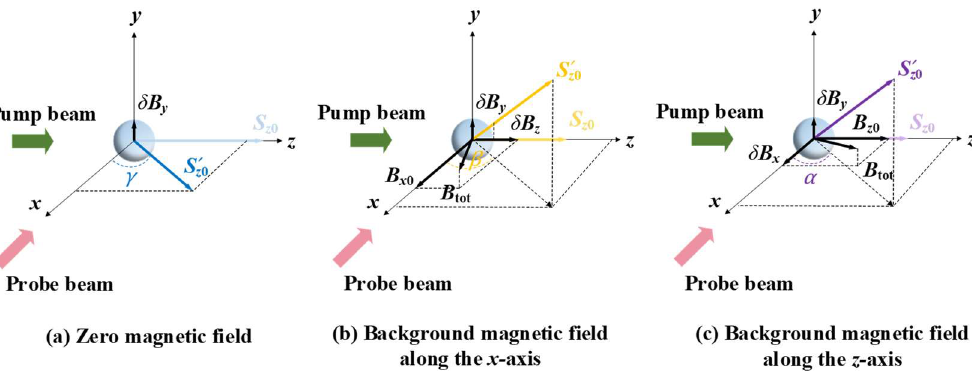
Figure 1. Atomic magnetometer spin vector evolution in ( a ) zero field and ( b , c ) background magnetic field. B tot is the composite vector field along the x -, y -, and z -axes. S z 0 and S z 0 ′ denote the initial spin vector aligned by the pump laser and the steady-state spin vector under the magnetic field.